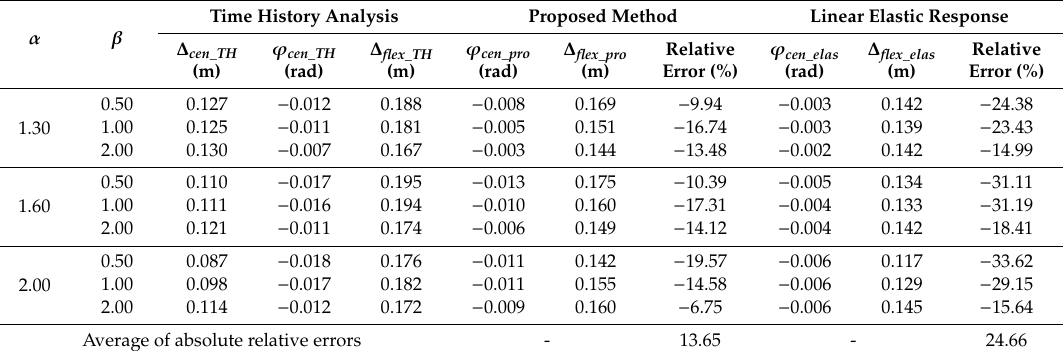
Table 5. Results of the time history analysis, the proposed method and the linear elastic response. (Kobe).